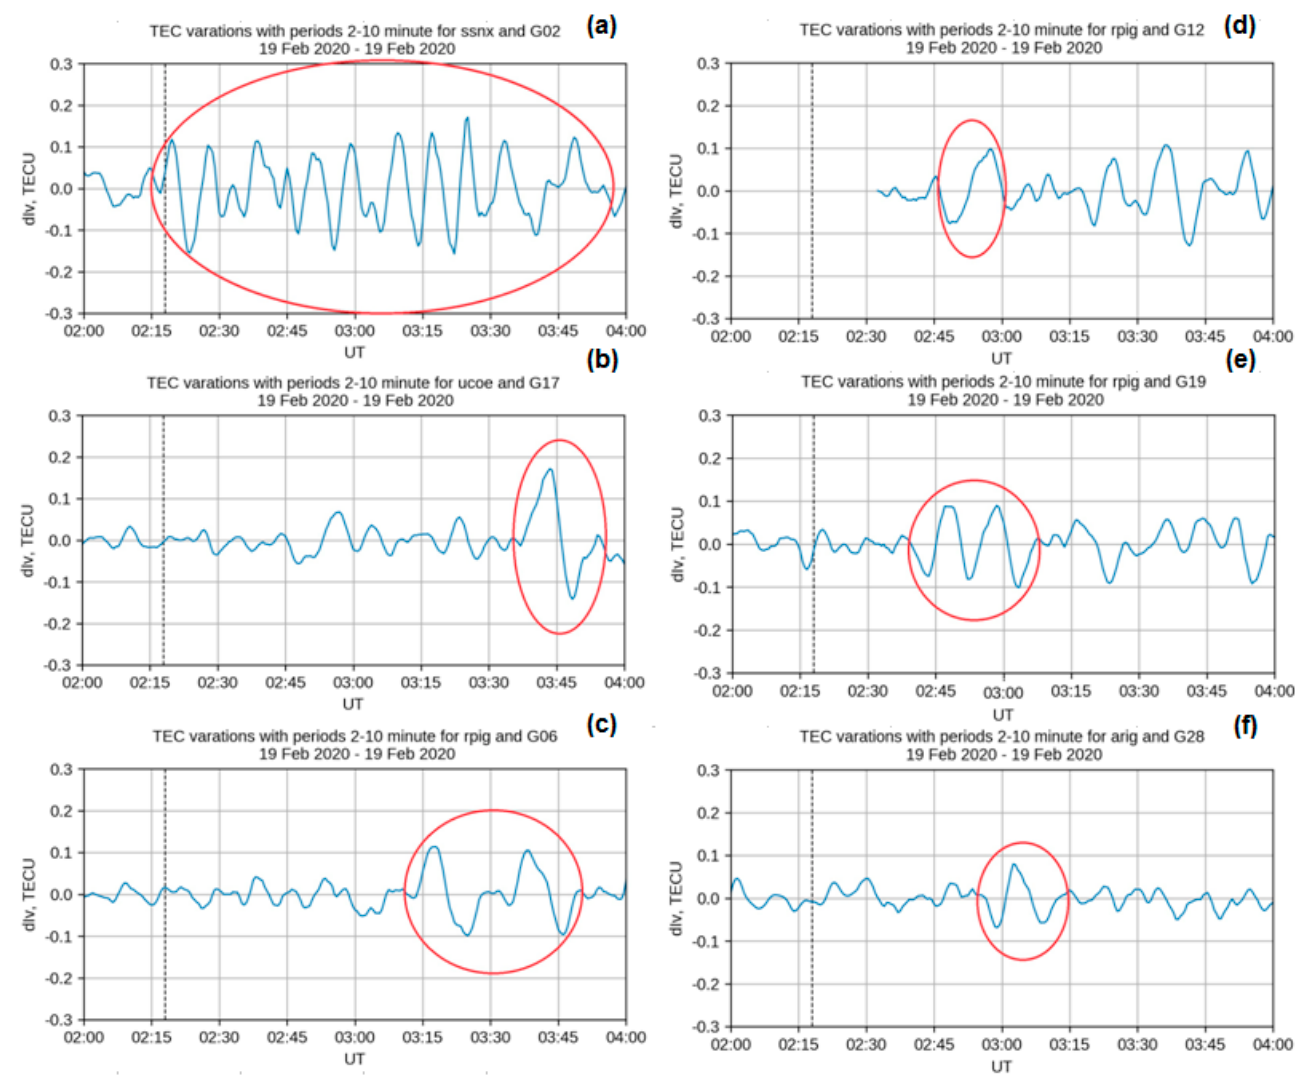
Figure 13. (2–10) min dIv series for lines-of-site ( a ) SSNX-PRN02, ( b ) UCOE-PRN17, ( c ) RPIG-PRN06, ( d ) RPIG-PRN12, ( e ) RPIG-PRN19 and ( f ) ARIG-PRN28.